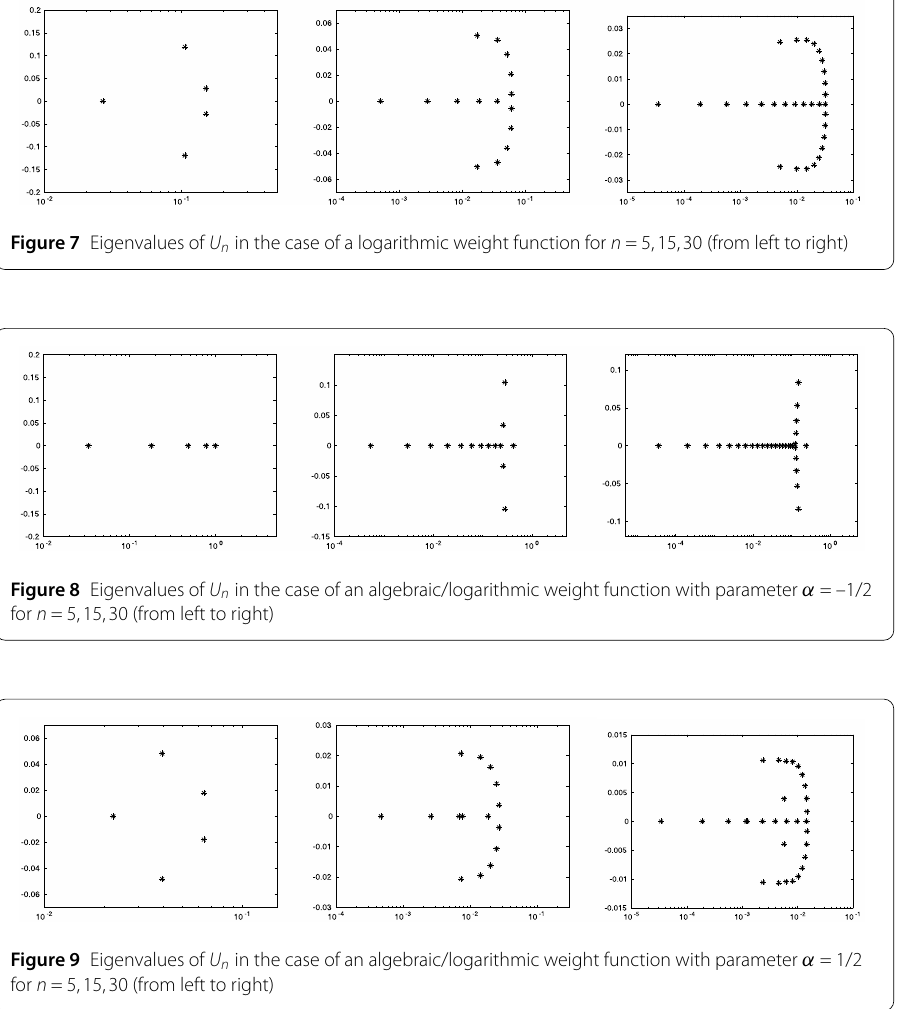
Example 3 Algebraic/logarithmic weight function w ( x ) = x α log (1/ x ) on [0,1] with α = (–0.9 : 0.1 : 5)(5.2 : 0.2 : 7)(7.5 : 0.5 :